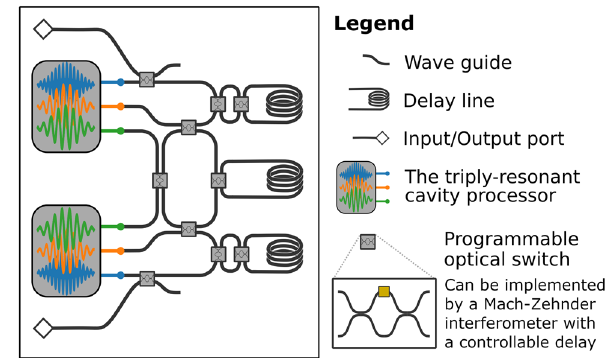
Fig. 3 Our minimal architecture for error correction of bosonic codes, readily expandable to larger tasks. The circuit depicted can be used to correct a single-photon loss using a two-mode bosonic code. The circuit consists of two cavity processors, which for the most part process each mode of the code separately, and a small network of reprogrammable beam splitters and delay lines. These are used to reroute states between the modes of processors as necessary. Each cavity processor is also capable of performing many multi-qubit gates for single- and dual-rail encoded qubits, as well as preparing and manipulating higher-number Fock states. The network of programmable beam splitters between the processors and the delay lines can also be expanded to a fully connected network, enabling universal rerouting between the three modes of each processor for general- purpose quantum computation. The programmable beam splitters can be implemented as Mach – Zehnder interferometers (as shown in the inset) with two 50/50 beam splitters and a programmable delay (the orange medium in the diagram). Classical electronics will be necessary to ensure the pacing of various operations in this device, but no feedback or decision circuitry is necessary, as the approach is measurement